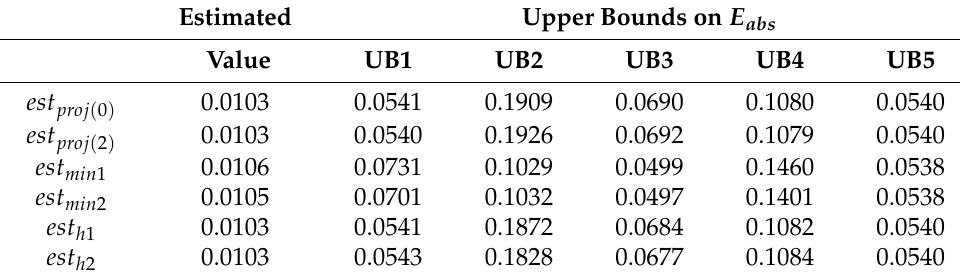
Table 1. Estimating x T A − 2 x = 0.0127, where A = B T B , B = Parter , x = e 100 .